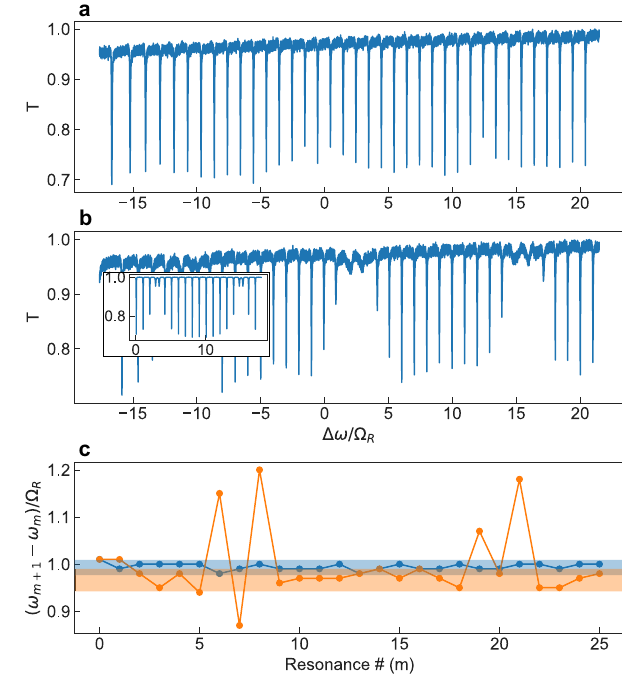
Fig. 2 Measurement of transmission through a static ring resonator and frequency separation of modes. Transmission spectrum without ( a ) and with ( b ) an auxiliary ring resonator coupled. Ω R = 5.35 MHz in ( a ), ( c ), Ω R = 5.25MHz in ( b ). L = 38.6 m, L L a ≈ 12, γ = 0.1, γ a / γ = 5. Inset in 0 0 / 0 0 ( b ) shows a numerical calculation of the transmission spectrum based on a scattering matrix model, similar to Fig. 1d, but with fi nite roundtrip losses in both the main ring and the auxiliary ring of 5%. c Frequency difference between adjacent resonances of the main ring without an auxiliary ring from ( a ) (blue), and with an auxiliary ring from ( b ) (orange), as a function of the order of the resonances.